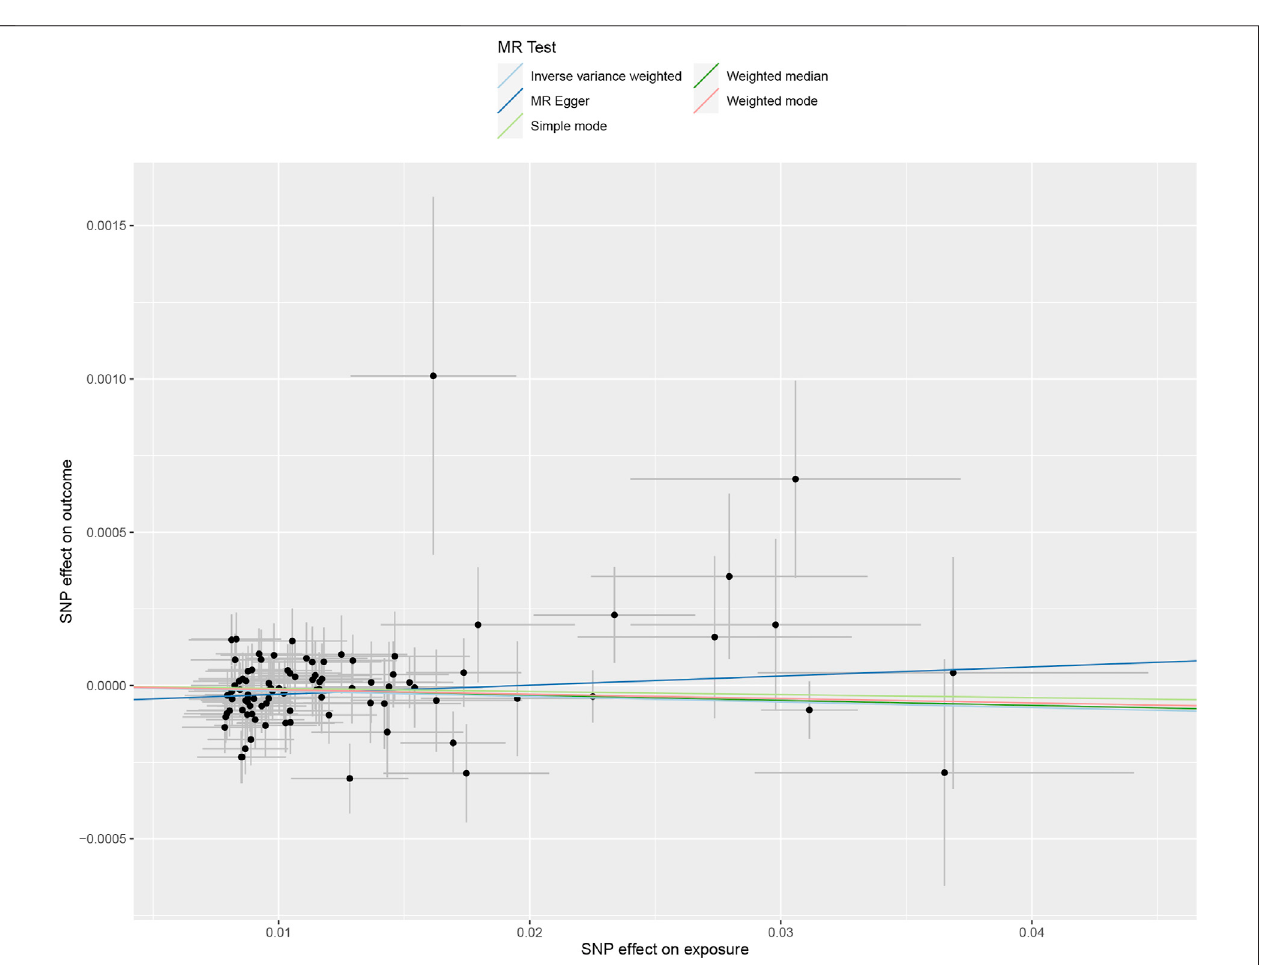
FIGURE 1 | Scatter plot to visualize the causal effect between tea consumption and obesity. The slope of the straight line indicates the magnitude of the causal association, scatter plot of inverse variance weighted (IVW) method, MR-Egger regression method, weighted median estimator (WME), weighted mode and simple mode. MR, Mendelian randomization; SNP, single nucleotide